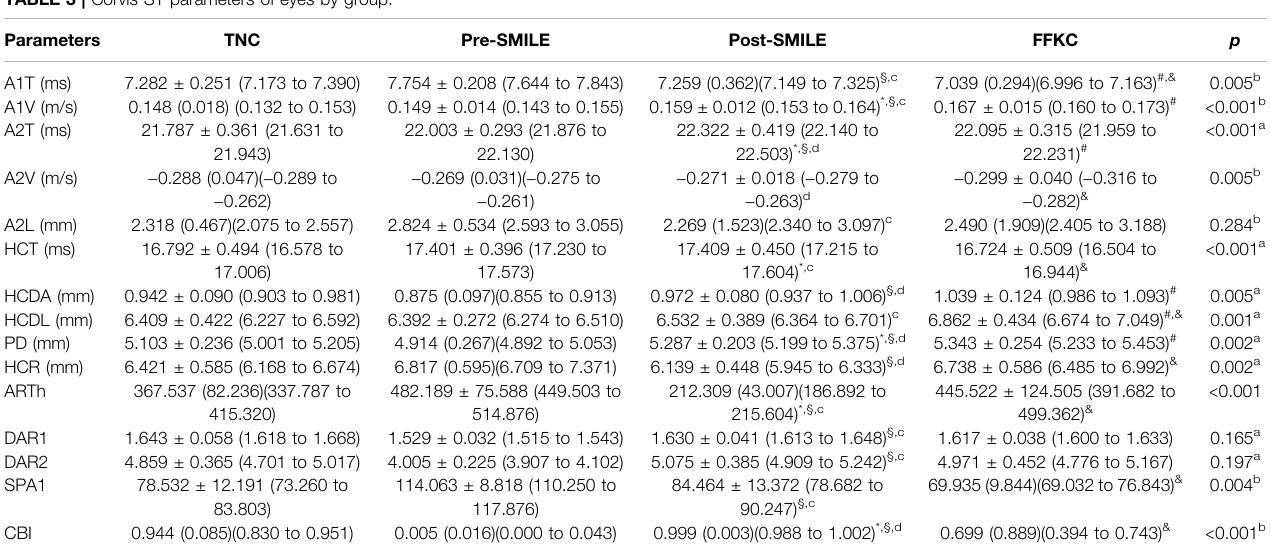
TABLE 3 | Corvis ST parameters of eyes by